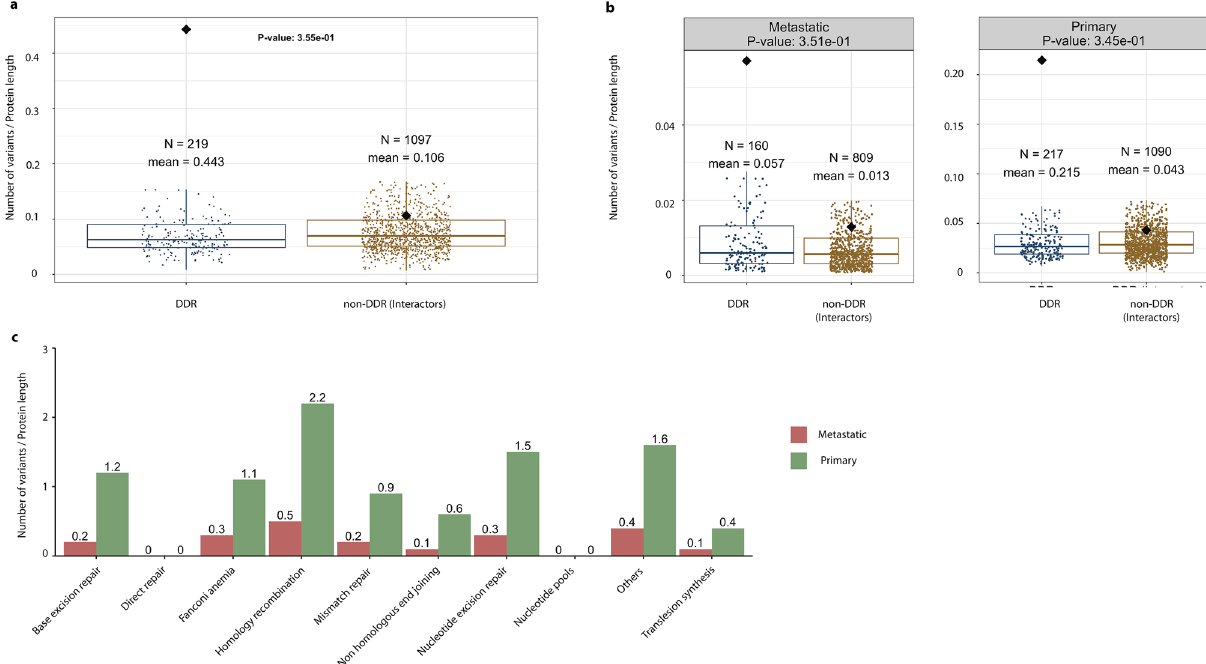
Figure 3. Distributions of somatic variants in DDR and non-DDR interactors. Boxplots showing the contrasting patterns in somatic variants as a function of protein length in DDR and non-DDR (panel a ), and as categorized into metastasis and primary tumours (panel b ). Outliers in panels ( a , b ) were removed for clarity, but retained for the T-test statistical analysis. Some genes occur in one or two of the categories in panel b , hence the sum of the N values is higher than in the corresponding plot in panel ( a ). The N in panel ( a ) indicates the number of unique DDR genes. All box plots depict the first and third quartiles as the lower and upper bounds of the box, with a thicker band inside the box showing the median value and whiskers representing 1.5 × the interquartile range. Panel ( c ) shows the accumulation of somatic variants in different biological pathways associated with the 229 DDR genes. For better visualization of the barplot we excluded TP53, which has a large number of recorded variants.